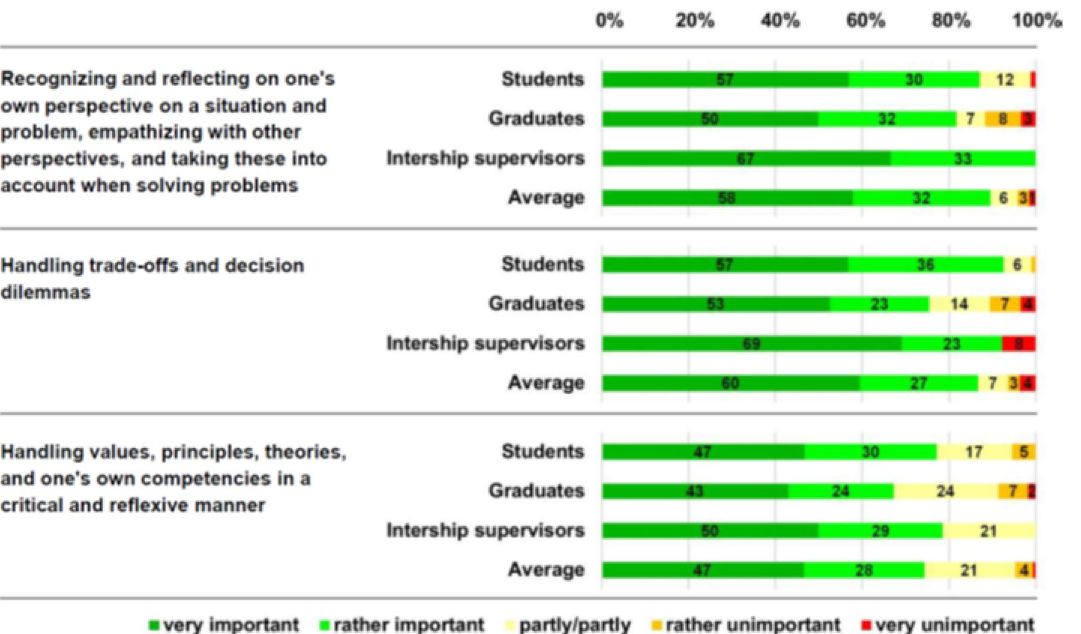
Fig. 7 Assessment regarding the importance of personal competencies for the intended professional activity (students), for the current pro- fessional activity (graduates), and for the professional fields (internship supervisors) (students are N = 93/95/92; graduates N = 60/57/58; and internship supervisors N = 12/13/14. In addition, the average of the three estimations is equally weighted)